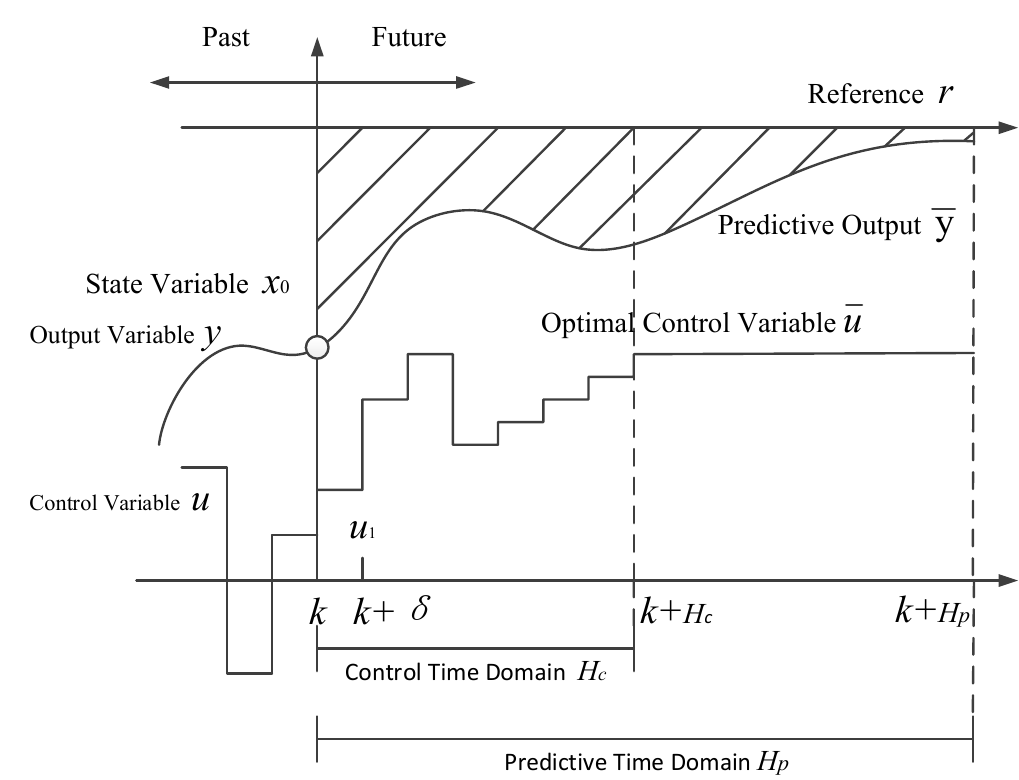
Figure 19. Schematic of model predictive control.